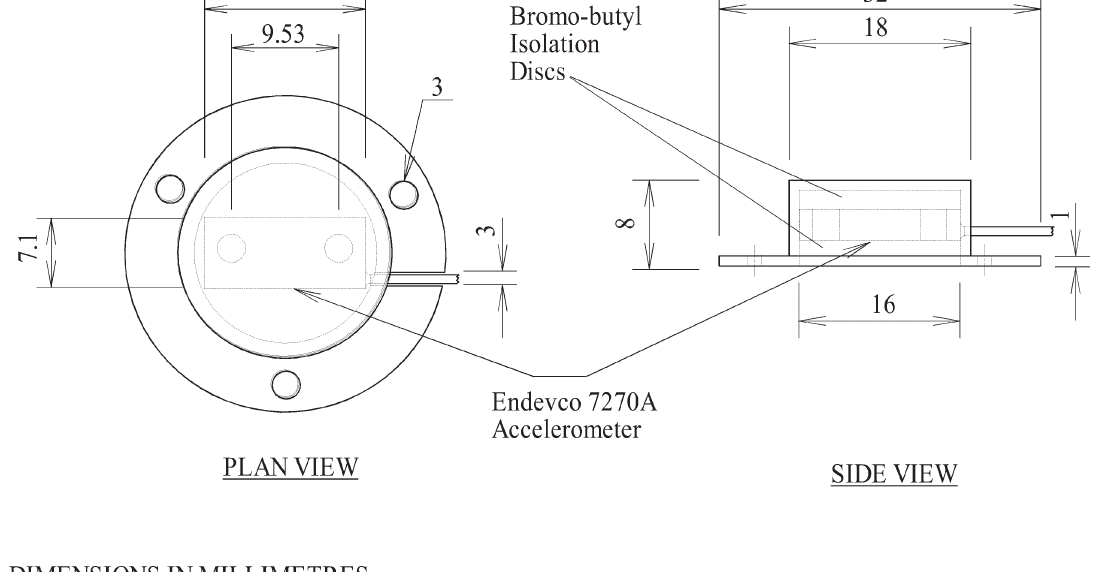
Fig. 4. Detail of the 7270A-AMRL assembly.